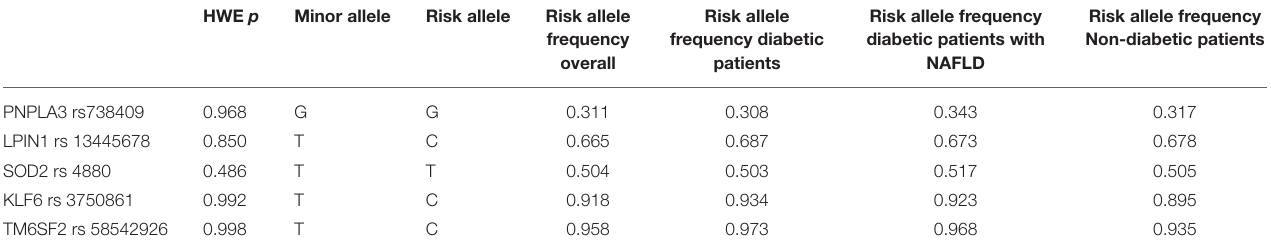
TABLE 2 | Frequency of PNPLA3 rs738409 , LPIN1 rs13412852 , SOD2 rs4880 , KLF6 rs3750861 , and TM6SF2 rs58542926 risk alleles in the study population.